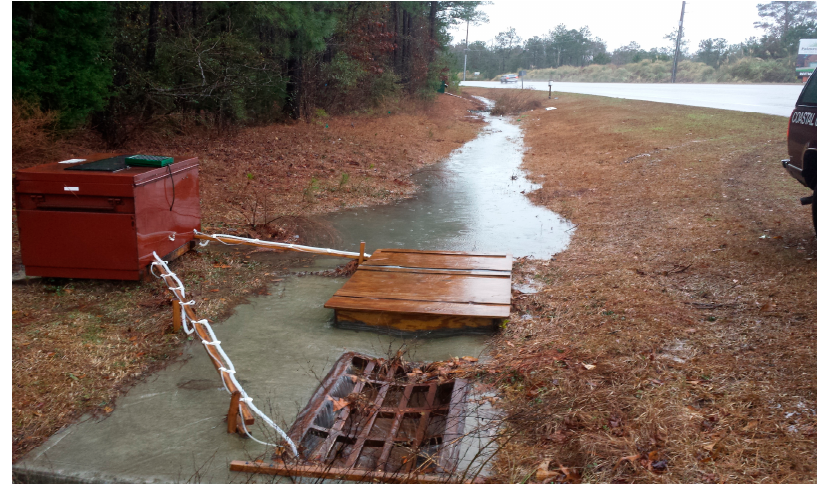
Figure 4. Bioswale outlet structure, with the upstream grate housing the underdrain monitoring and the downstream grate housing the overflow monitoring. The completed bioswale is present in the background.